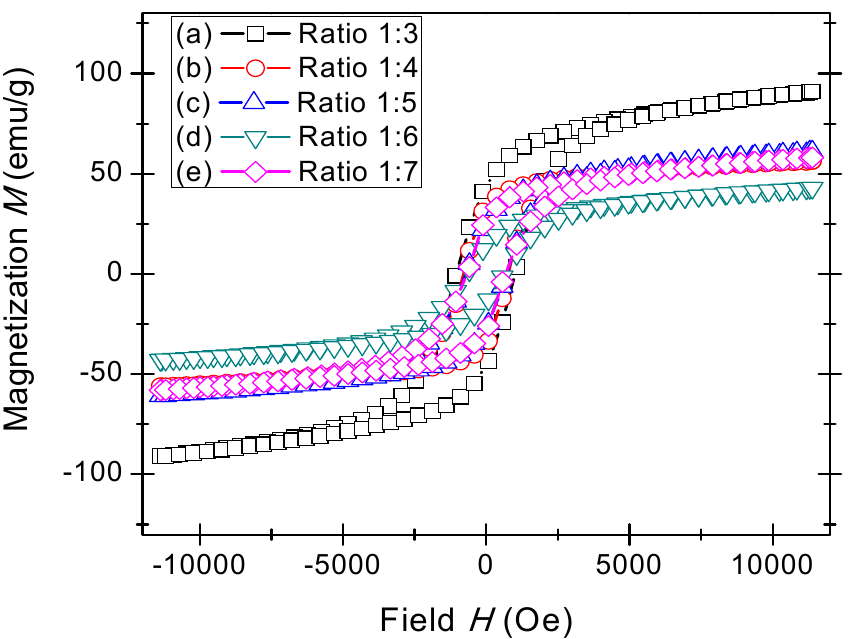
Figure 6. Hysteresis loop of BaFe 12 O 19 at different ratios ( a ) 1:3, ( b ) 1:4, ( c ) 1:5, ( d ) 1:6, and ( e ) 1:7.